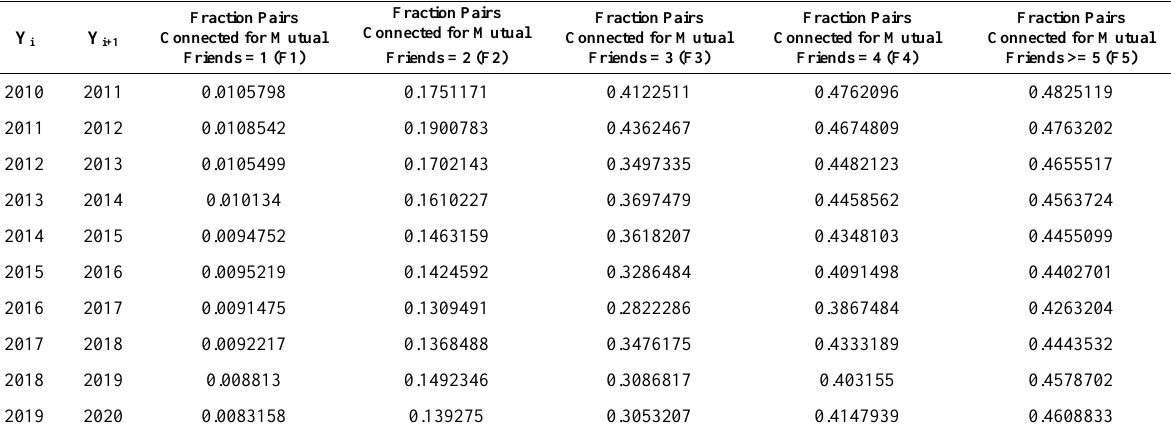
Table 3. Shared Affiliation Bias Evaluation in UK